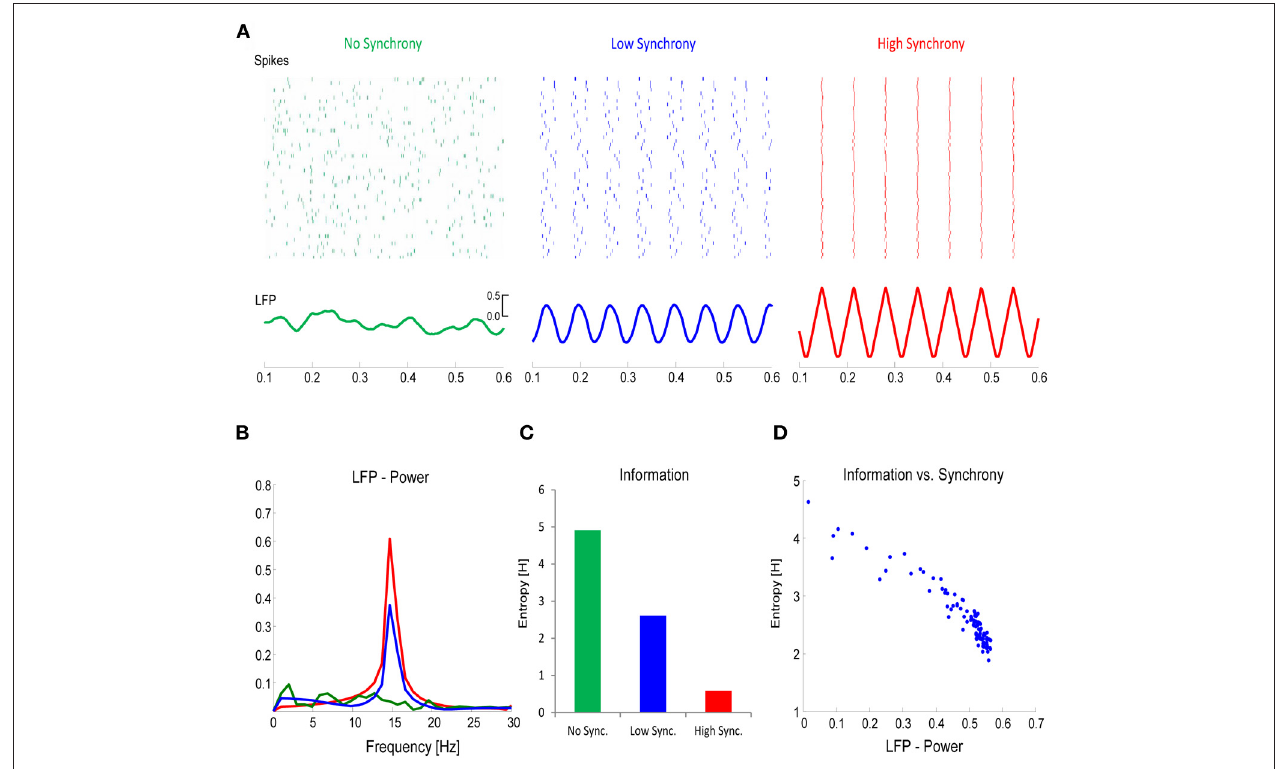
FIGURE 6 | The link between desynchronization and information. (A) Firing rates for a population of neurons ( N = 50) was simulated with either no synchrony (left panel), a low degree of synchrony (middle panel), or a high degree of synchrony (right panel). The total number of spikes in each population was the same. The lower panels plot the corresponding local field potentials (LFP). (B) The power (15Hz) in the LFP increases